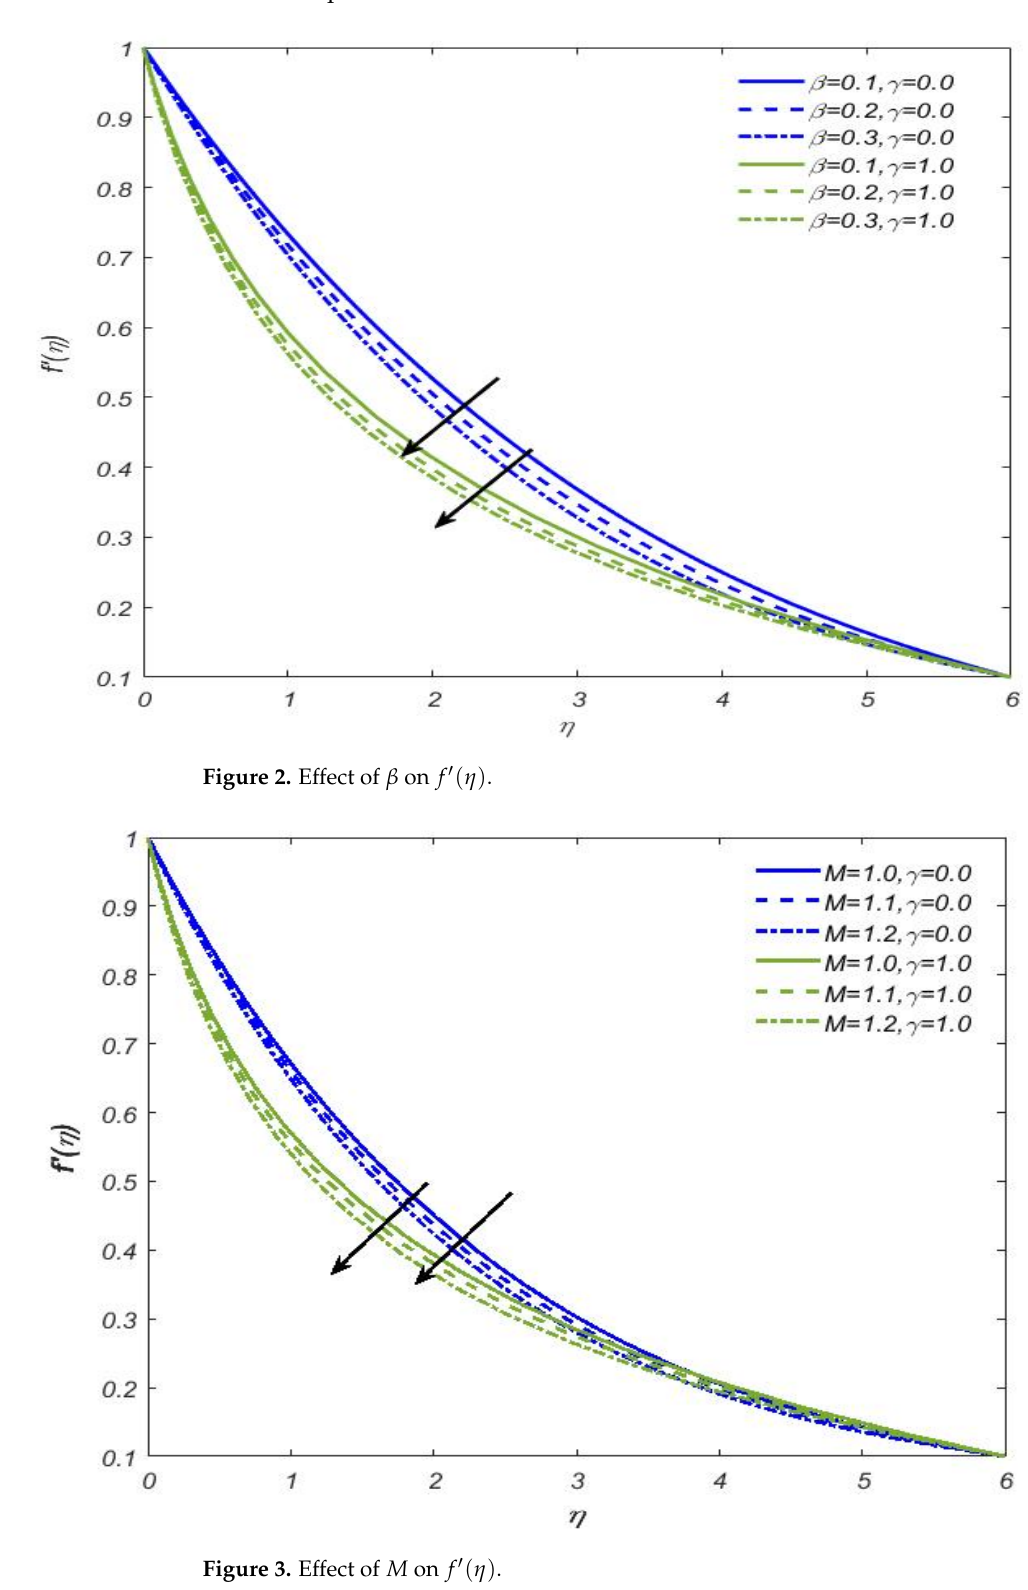
Figure 3. Effect of M on f (cid:48) ( η )